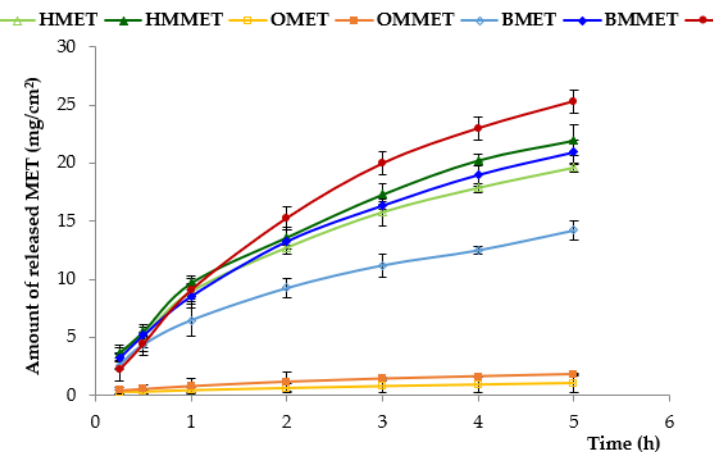
Figure 5. In vitro release from hydrogels, oleogels and bigels containing MET (HMET, OMET, BMET) or MMET (HMMET, OMMET, BMMET) and commercially available product (C).